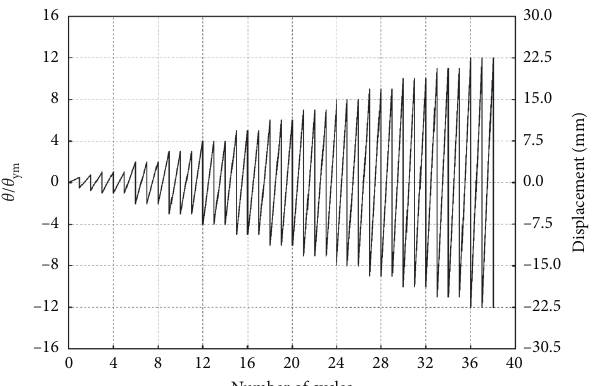
Figure 4: Loading